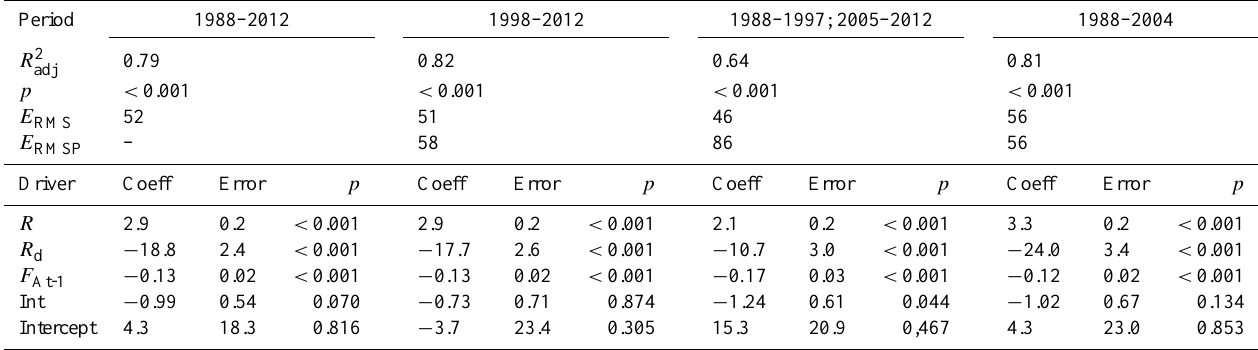
Table A5. Analysis of predictive accuracy of the final model based on the full 1988–2012 calibration period and the subsets for the 1998–